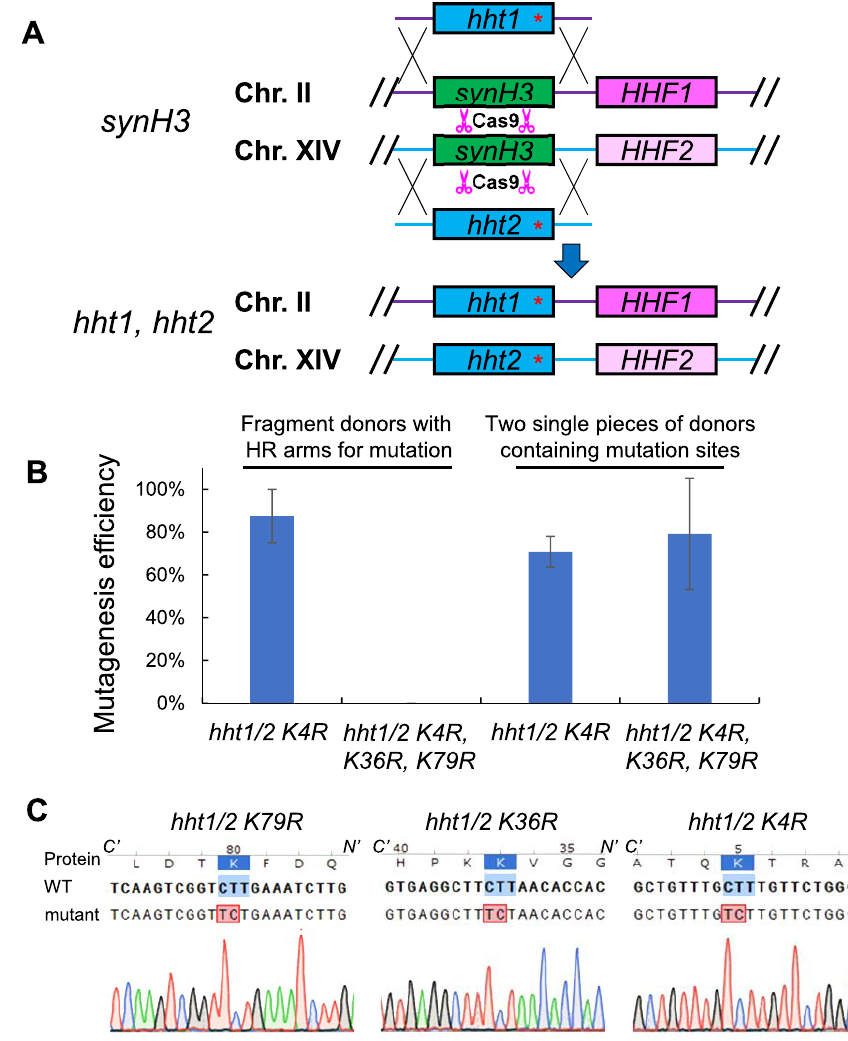
Figure 3. Generation of histone H3 single and triple mutants through a single transformation. ( A ) Graphic representation of CRISPR-Cas9 based mutagenesis on histone H3. The transformation was performed on synH3 strain with 2 targeting gRNAs and donors harboring mutation sites and HR regions. The single piece donors were generated through fusion PCR. ( B ) The mutagenesis efficiencies for generating histone H3 single and triple mutant through transformation with different formats of donors. The repairing donors can be prepared by either multiple donor fragments with flanking HR arms for mutation or two single pieces of donors containing mutation sites. The data of bar charts represent mean averages of over-all mutagenesis efficiencies of 3 biological replicates with each randomly picked 8 colonies. The error bars indicate the standard deviations of 3 biological replicates. ( C ) The representation of sequencing results of both Histone H3 K4R–K36R–K79R at endogenous loci. The sequence alignments were performed by SnapGene